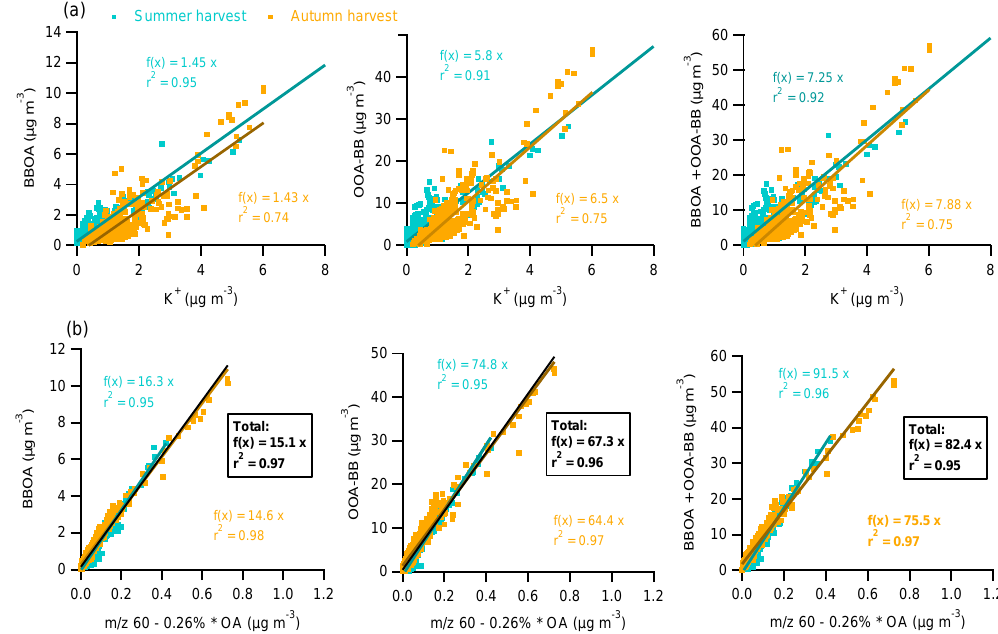
Figure 5. Comparison of biomass-burning-related PMF factors (BBOA and OOA-BB) and biomass-related species: (a) K + and (b) the ACSM m/z 60 minus 0.26% × OA (applied metric of background f 60 = 0 . 26% of OA is discussed in the Sect. 3.4 of the text) during the summer and autumn harvest.